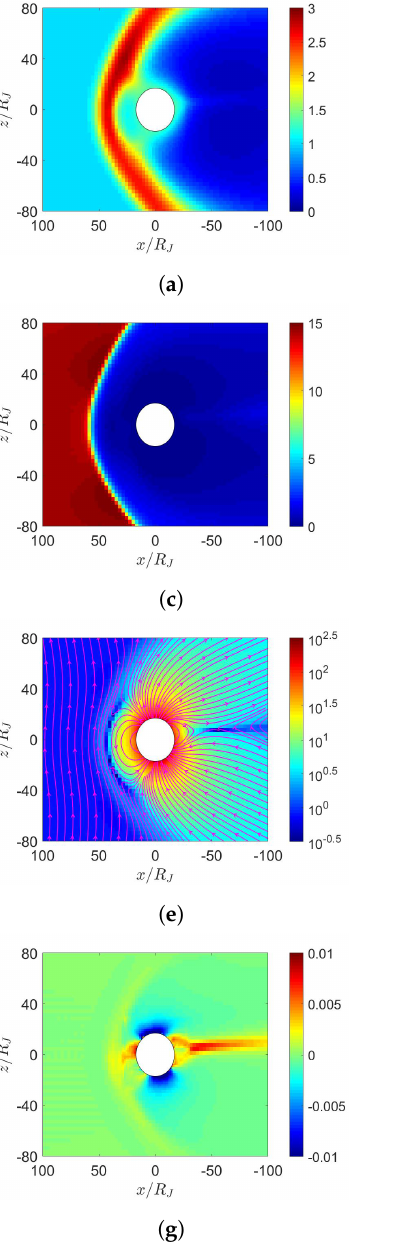
Figure 11. Distributions around Jupiter of ( a ) n (cm − 3 ), ( b ) ¯ u xz (km/s), ( c ) magnetosonic Mach number, ( d ) P (nPa), ( e ) ¯ B xz (nT), ( f ) J y (nA/m 2 ), ( g ) J r (nA/m 2 ); maximum dipole tilt points towards sun at t = 0, under northward IMF, t = 21.19